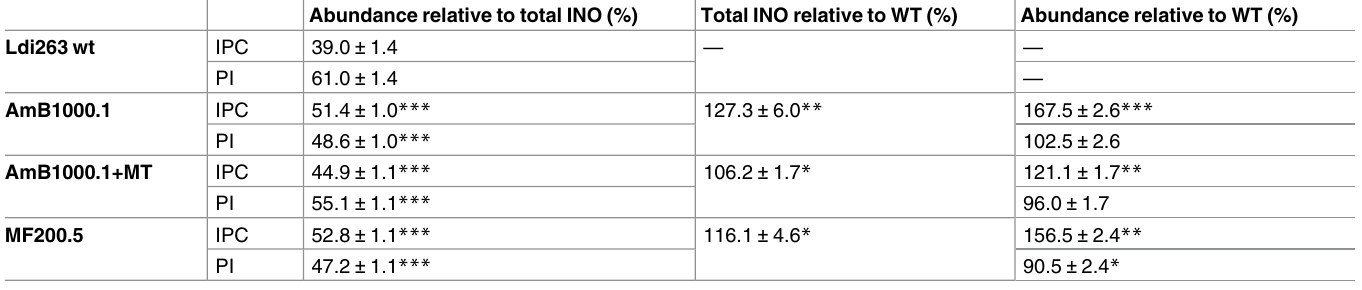
Table 3. IPC/PI ratio and total inositol quantification relativeto the wild-type strain. Data are the mean ± s.d. of two independent experiments run in trip- licate. Statistical significanceof INO betweenthe mock-transfected wild-typeand the rest of the strains was evaluatedby unpairedtwo-tailedt test ( * p (cid:20) 0 . 05 , ** p (cid:20) 0 . 01 , *** p (cid:20) 0 . 001